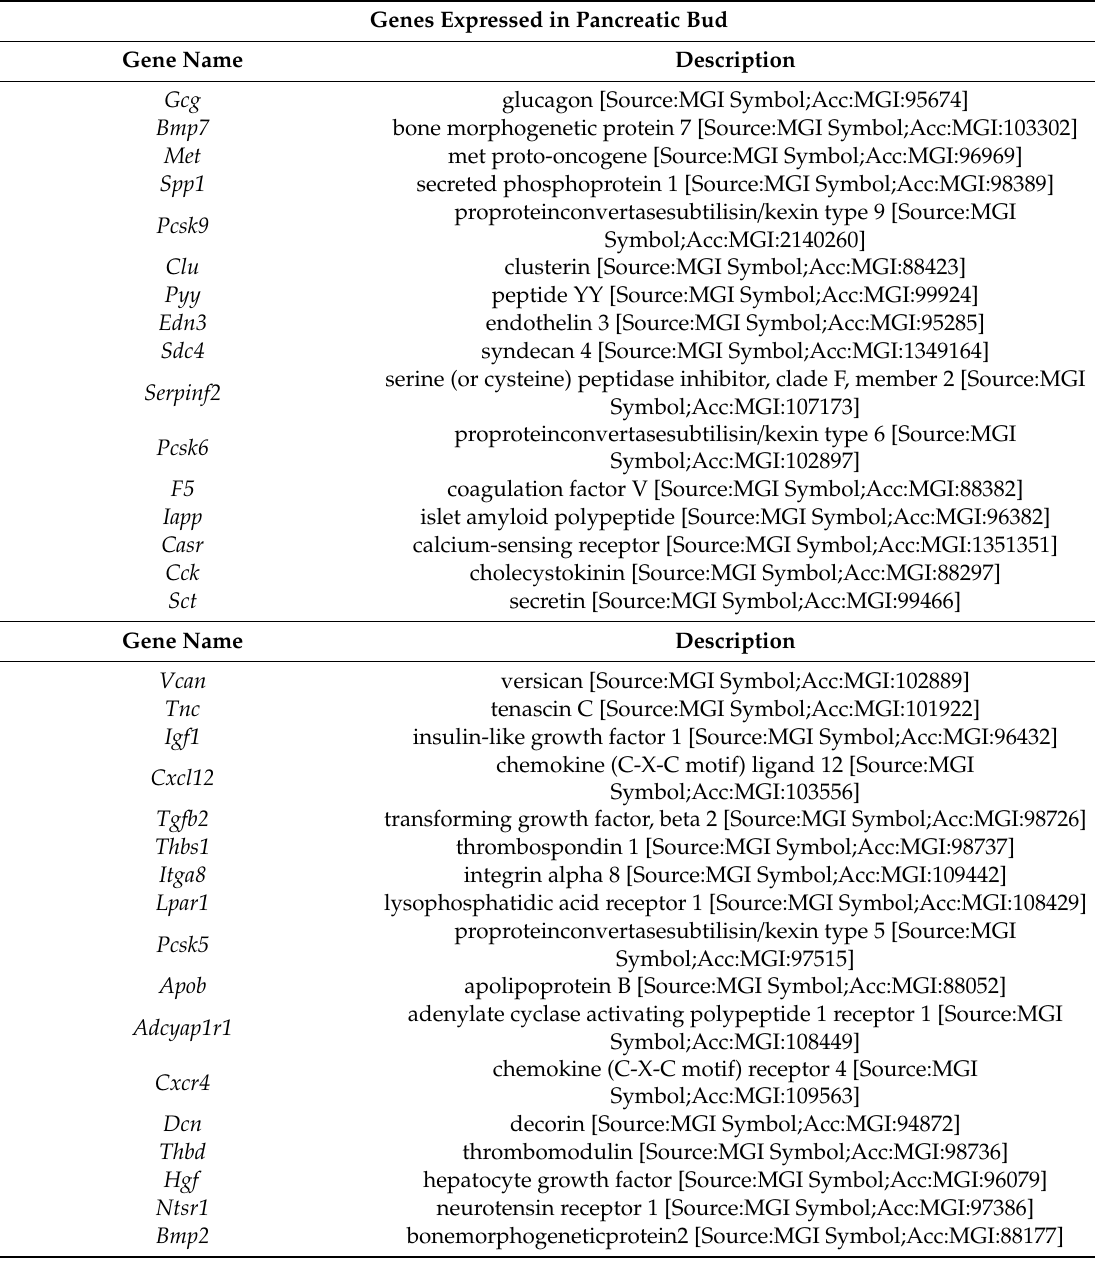
Table 3. List of the crosstalk between pancreatic bud and mesenchyme. According to their scores (rank = 1), we obtained putative crosstalking interactions (16 bud and 17 mesenchymal